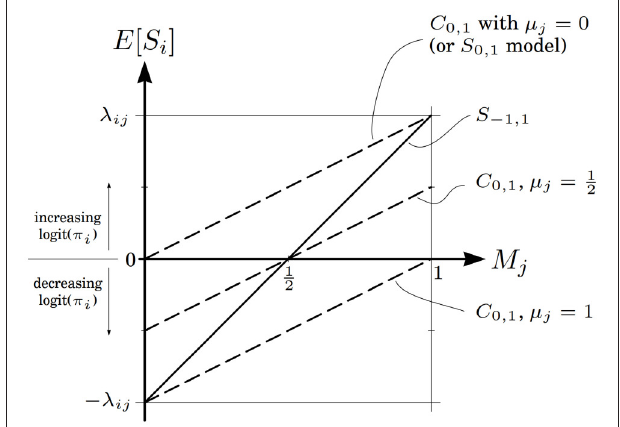
FIGURE 3 | Expected value of the neighbor effect of variable j on variable i , as a function of M j , the marginal probability that Z j takes the high level. The solid line is for the symmetric model, and dashed lines are for the centered model with different µ j values. The line for the standard zero/one model coincides with the uppermost dashed